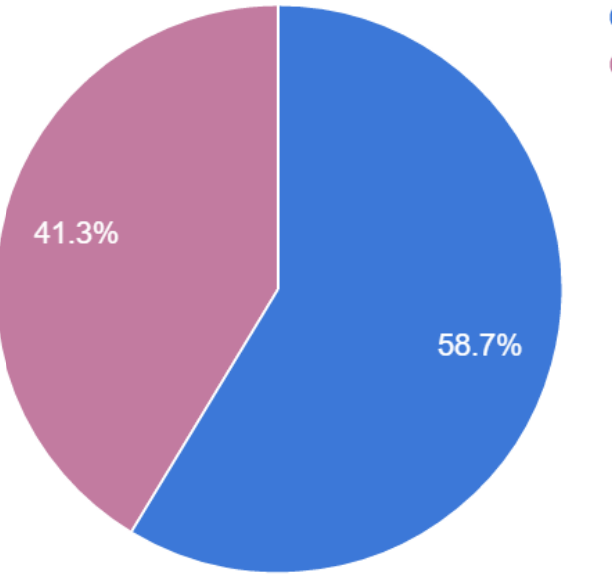
Figure 2. Twitter Participation by Gender.